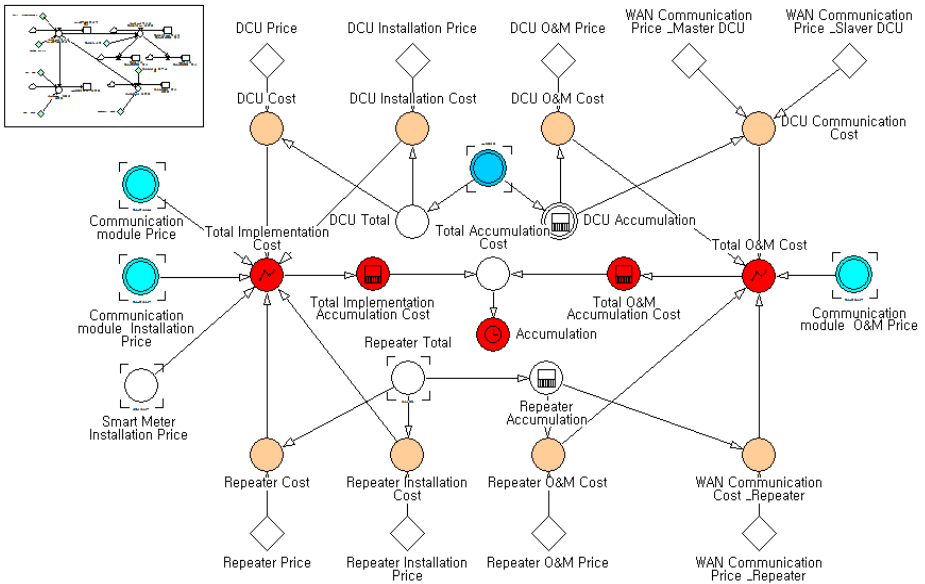
Figure 3. System Dynamics Modeling for Hybrid AMI.